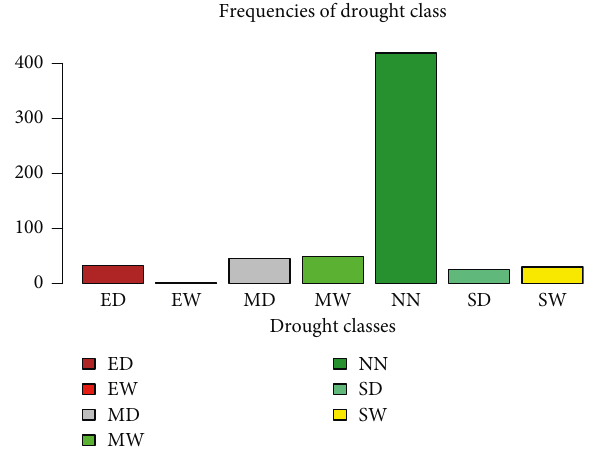
Figure 4: Frequencies of drought classes at Astor station.